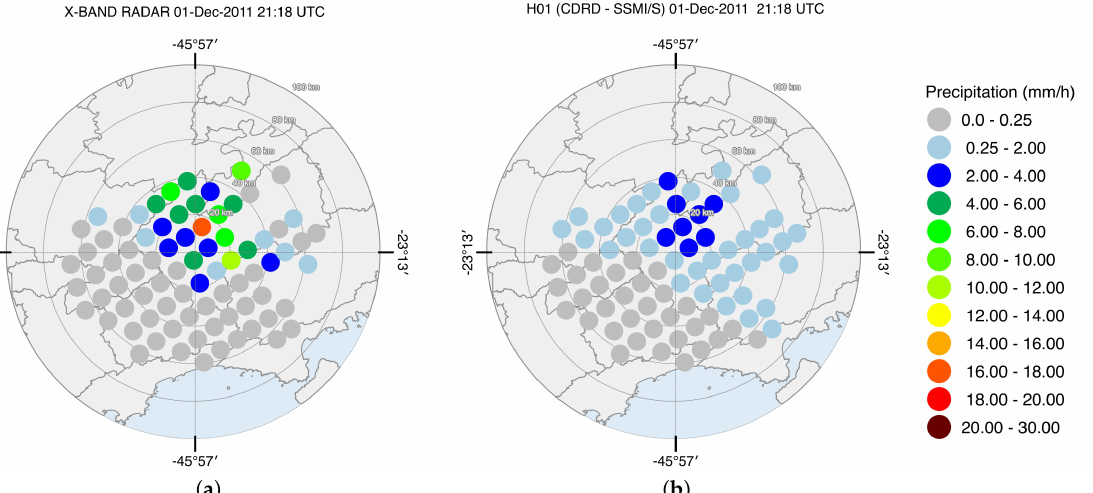
Figure 17. ( a ) Rain rate from radar upscaled to the satellite grid and ( b ) H01 rain rate map in Vale do Paraíba on 1 December 2011 at 21:18